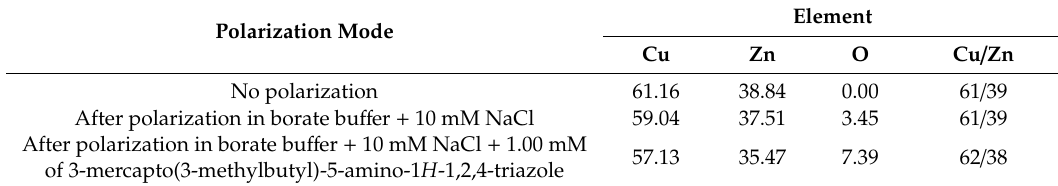
Table 4. Elemental surface composition (at. %) of the brass electrode.